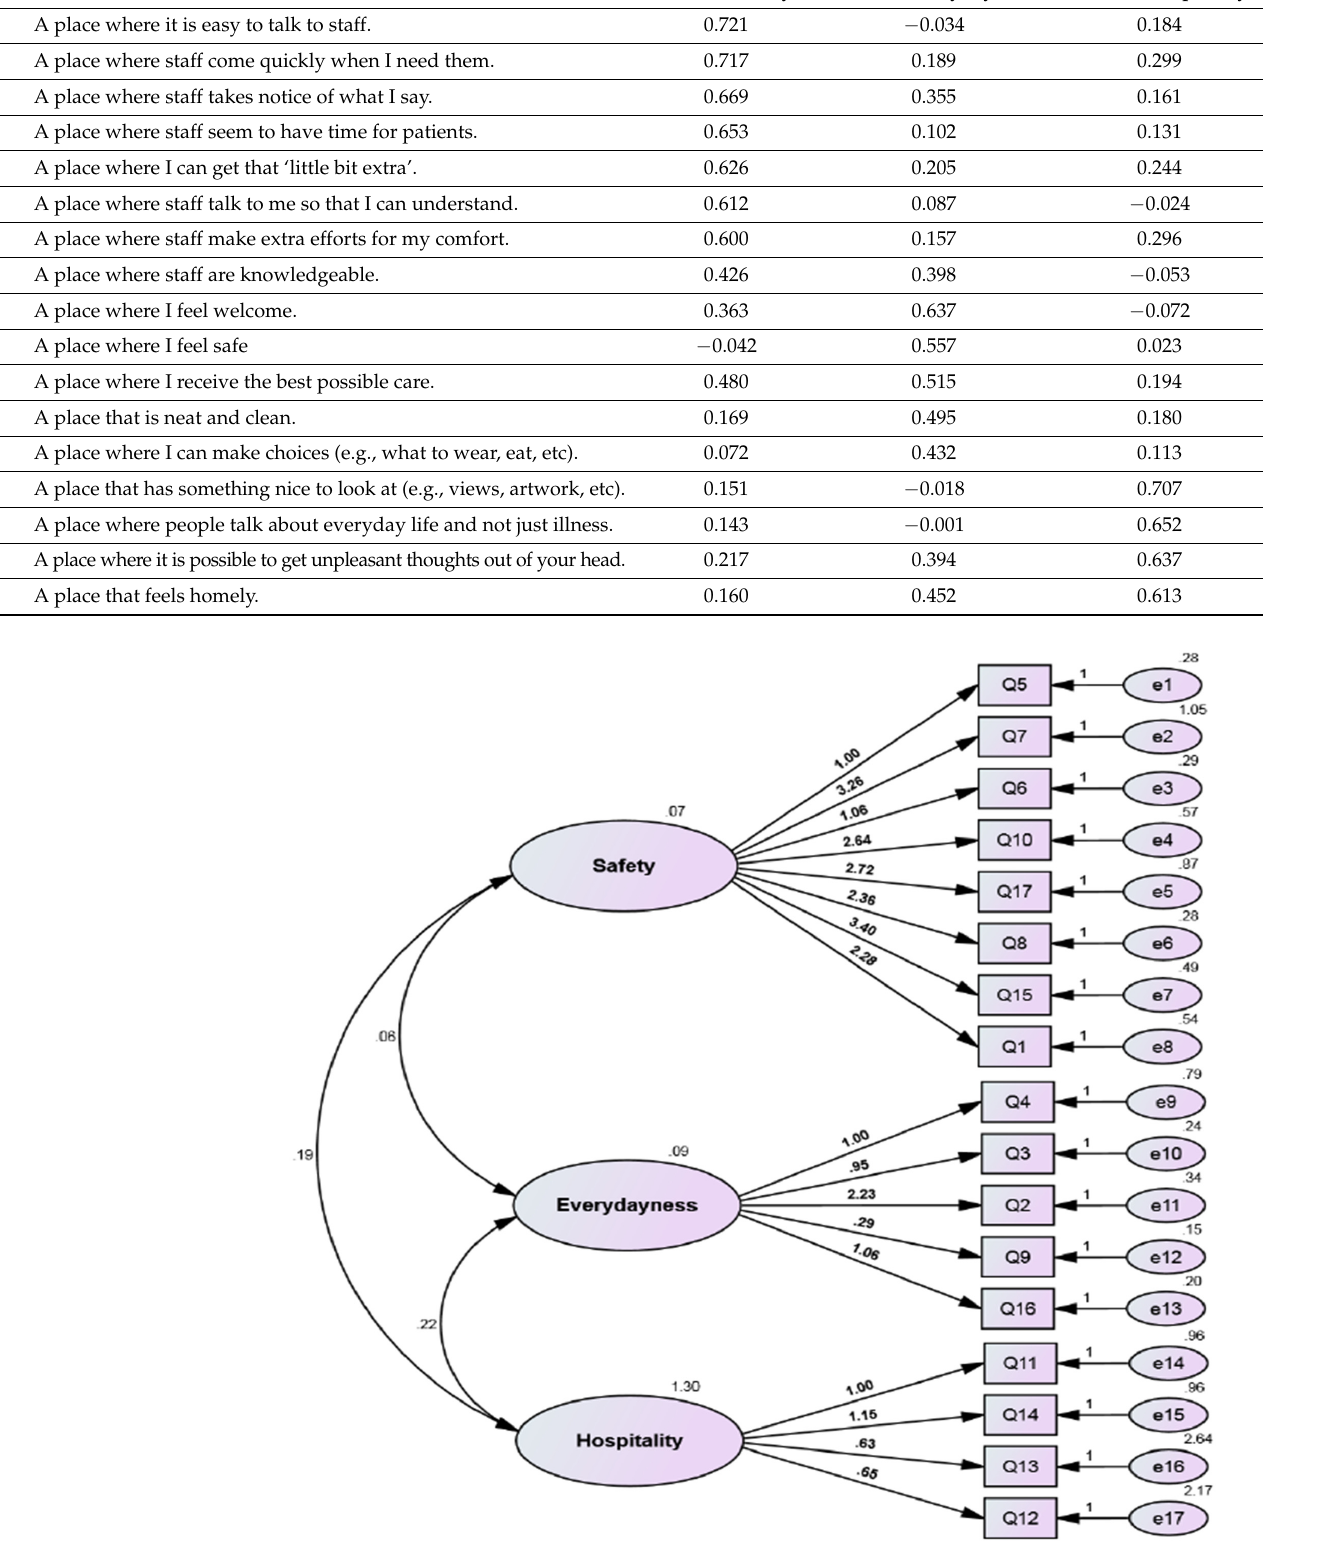
Figure 2. Confirmatory factor analysis of the three factors. Table 5. The quality indicators of the model.